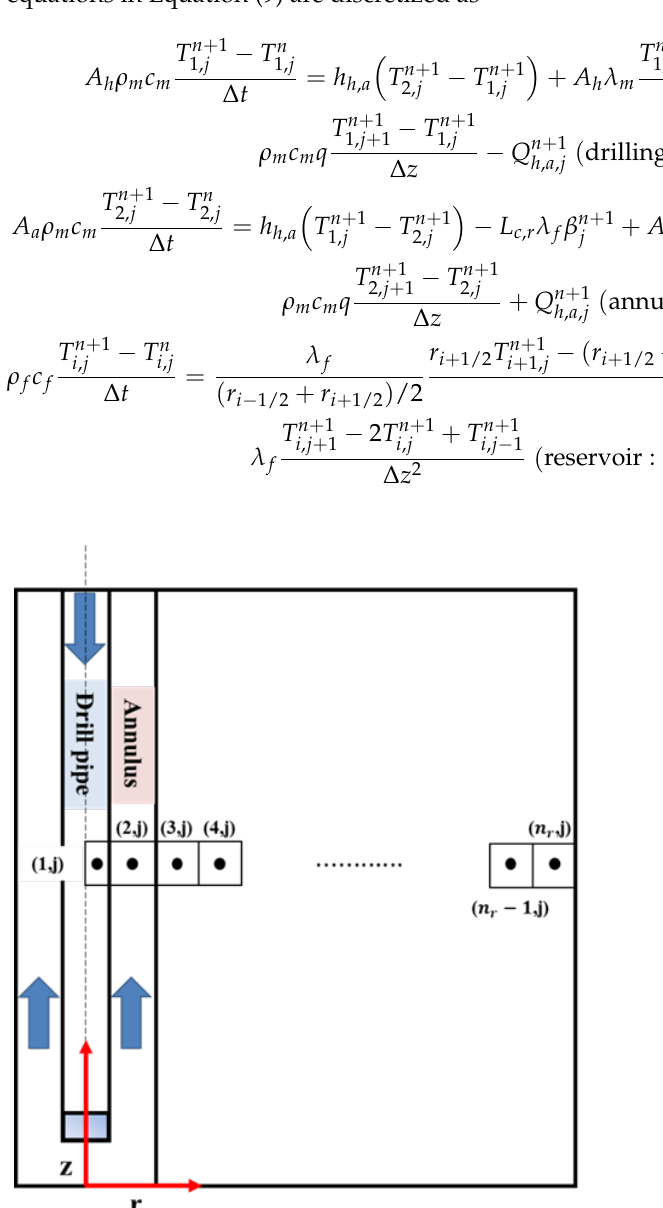
Figure 2. Scheme for numerical simulation of drill pipe, annulus, and formation. Note that T h = T i = 1 , T a = T i = 2 , and T f = T i ≥ 3 . The subscripts i and j and the superscript n indicate indices for r , z , and t , respectively. The discretization sizes ∆ r , ∆ z , and ∆ t are defined as